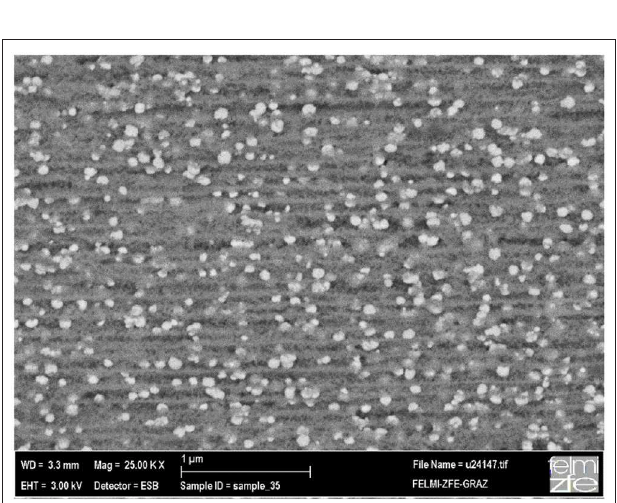
FIGURE 13 | Cross-sectional back scattered electron micrograph (BSE) showing the distribution of sphere-like Ni deposits within porous silicon. Rumpf et al. [ 82], IOP with permission.